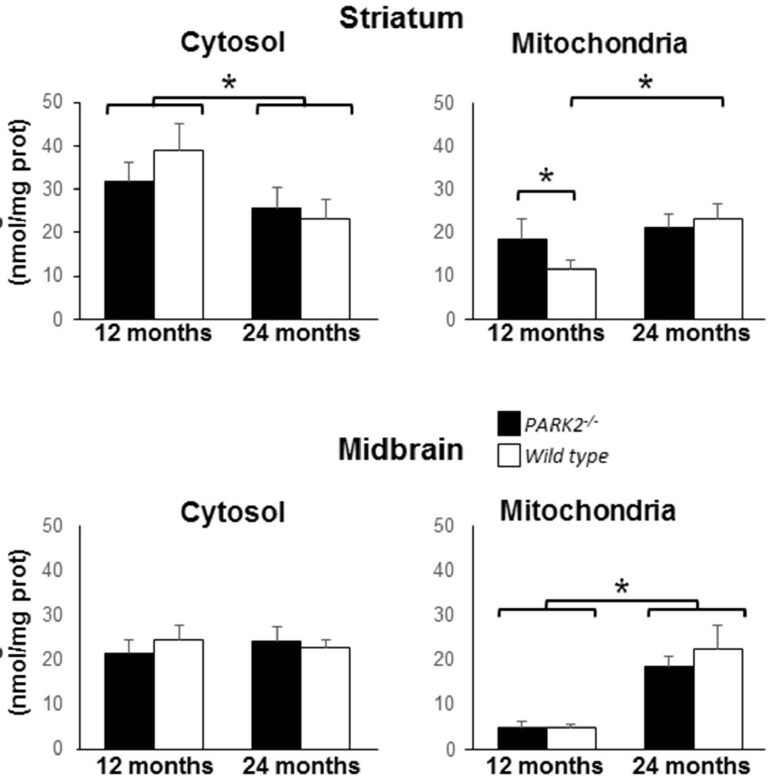
Figure 5. Increase of the mitochondrial glutathione content in striatum of 12-month-old PARK2 2 / 2 mice. Total glutathione (GSH + GS-SG) levels were determined in cytosols and isolated mitochondria from ventral midbrain and striatum of 12- and 24-month-old PARK2 2 / 2 (black bars) and wild-type mice (white bars), data are expressed as mean and SD of five independent measurements for each age and each genotype. *=p , 0.05 using multiple comparison with Holm-Sidak test. Significant differences with age, without influence of the genotype, were observed for midbrain mitochondrial and striatal cytosolic glutathione content. Significant interaction between age and genotype was present for striatal mitochondrial glutathione content, which significantly increased with age only in wild type mice and was at 12 months of age significantly higher in PARK2 2 / 2 than in wild type mice.